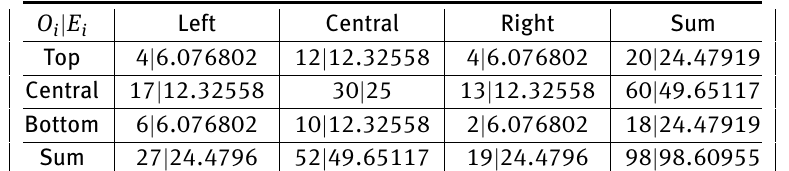
O i | E i Left Central Right Sum Top 4 | 6.076802 12 | 12.32558 4 | 6.076802 20 | 24.47919 Central 17 | 12.32558 30 | 25 13 | 12.32558 60 | 49.65117 Bottom 6 | 6.076802 10 | 12.32558 2 | 6.076802 18 | 24.47919 Sum 27 | 24.4796 52 | 49.65117 19 | 24.4796 98 |